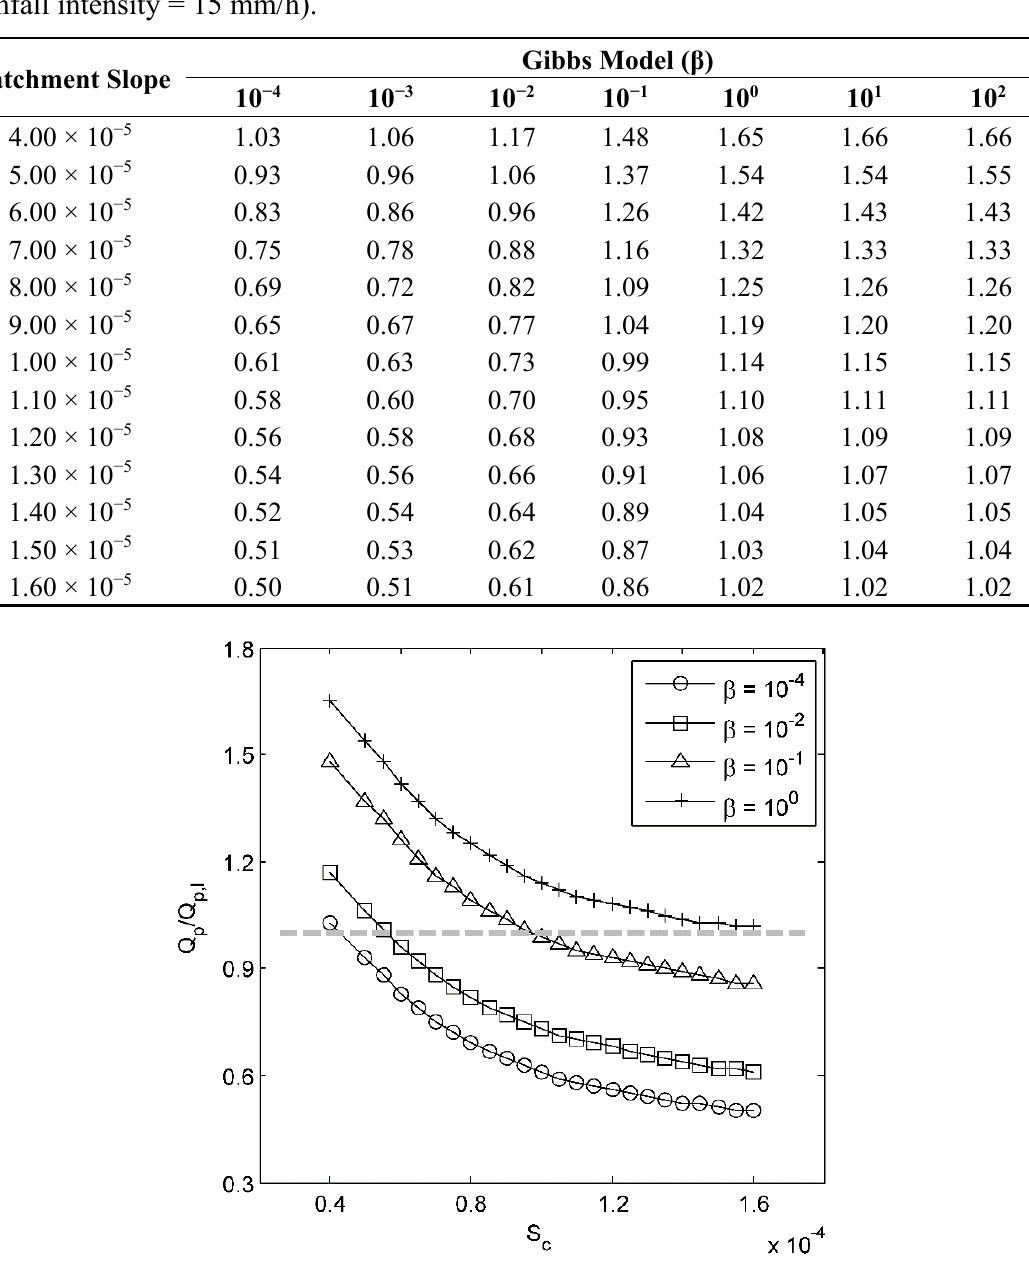
Figure 6. Averaged peak flow ratio ( Q p / Q p,l ) of dendritic drainage networks generated with the Gibbsian model to the fully looped network depending on the catchment slope (rainfall intensity = 15